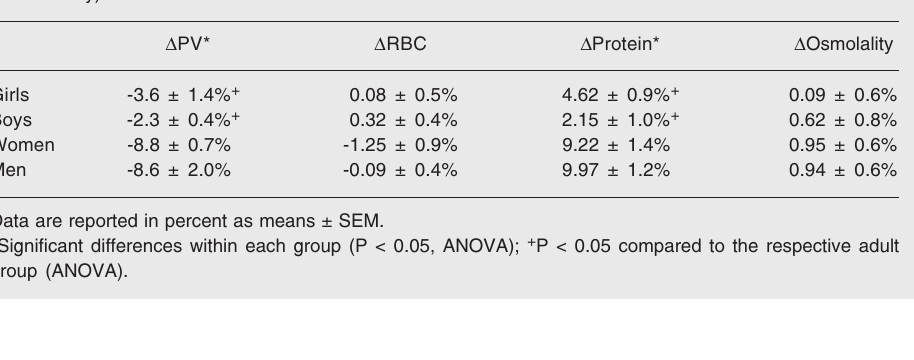
Table 6. Changes in plasma volume ( ∆ PV), red blood cells ( ∆ RBC), plasma protein ( ∆ Protein), and osmolality ( ∆ Osmolality) from rest to the end of exercise.